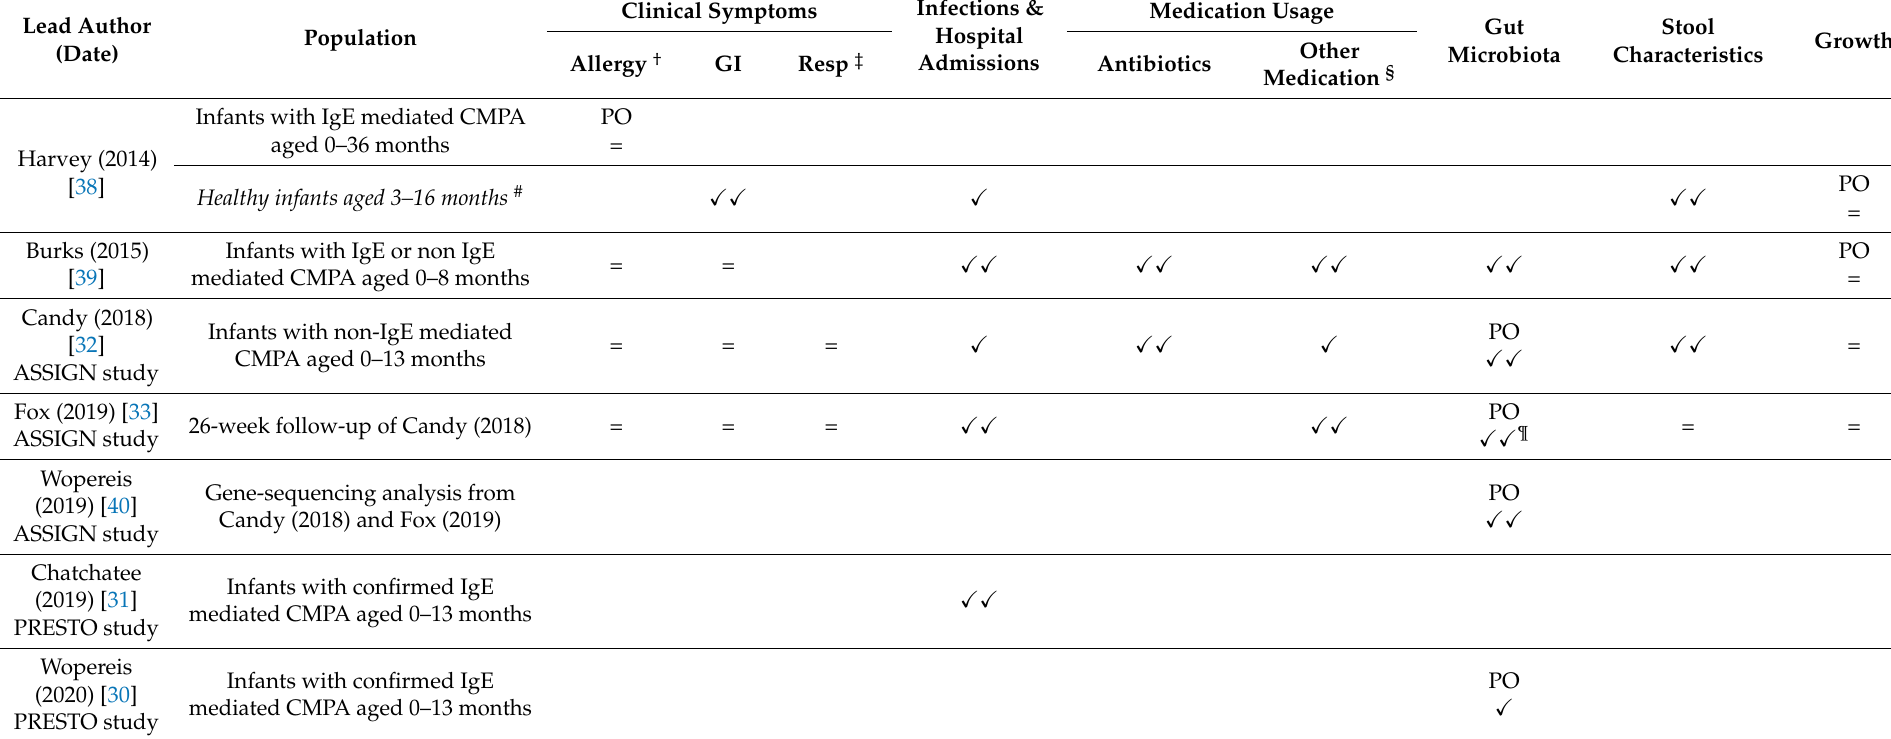
Table 2. Summary of key outcomes from included